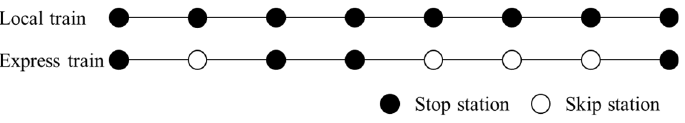
Figure 1. E/L mode.